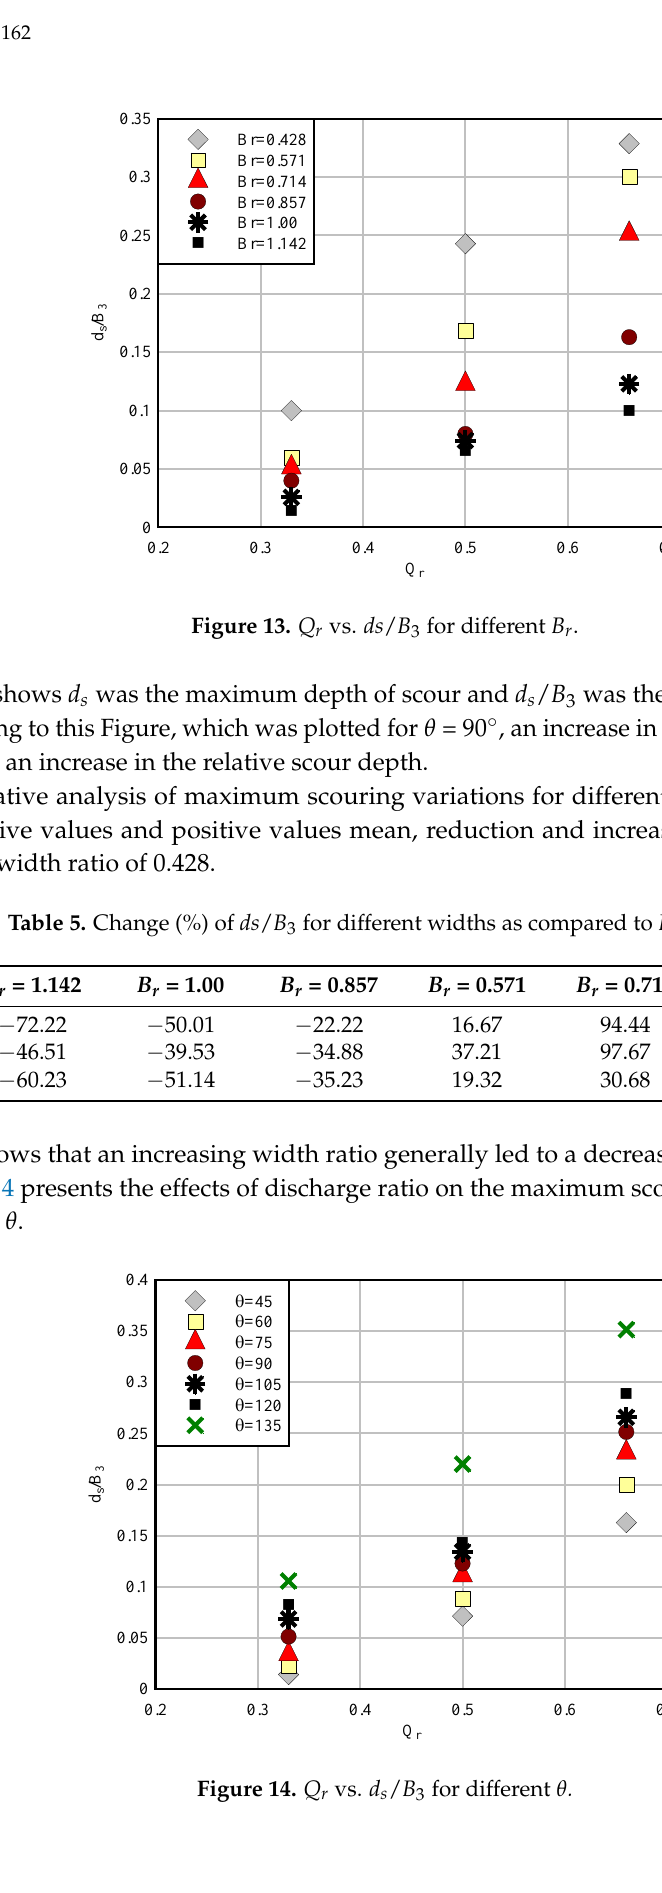
Table 6. Change (%) of D s / B 3 for different θ as compared to θ = 90°.